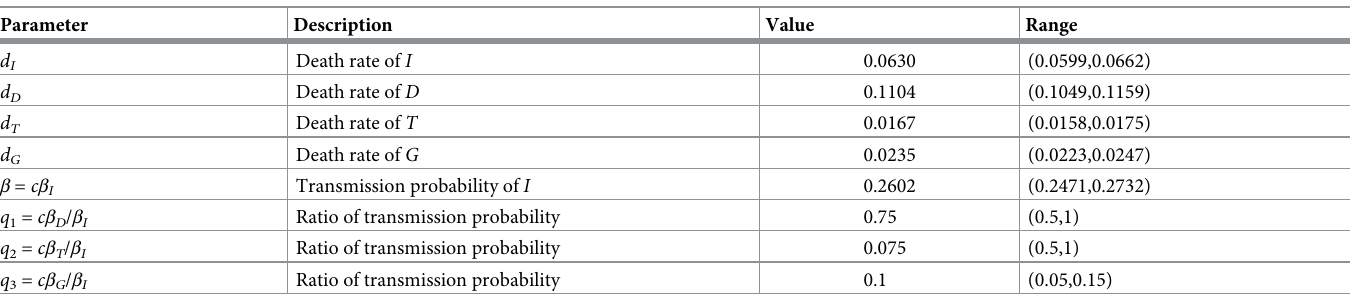
Table 5. Ranges of model parameter values for sensitive analysis.